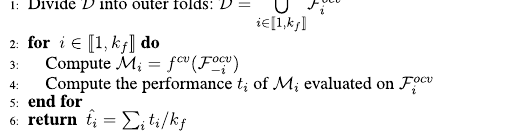
Algorithm 2. Nested